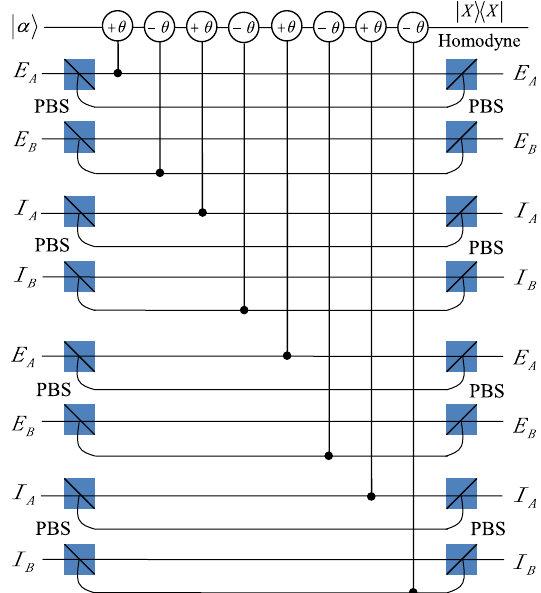
Figure 1. Schematic diagram of the principle of P-QND constructed by the cross-Kerr nonlinearity, one can distinguish the states θ and 0 of the coherent state, respectively. ± shifts of the coherent probe beam. PBS denotes the polarizing beam splitter which is used to reflect the vertical ( V ) polarization photon and transmit the horizontal ( H ) polarization photon, respectively.